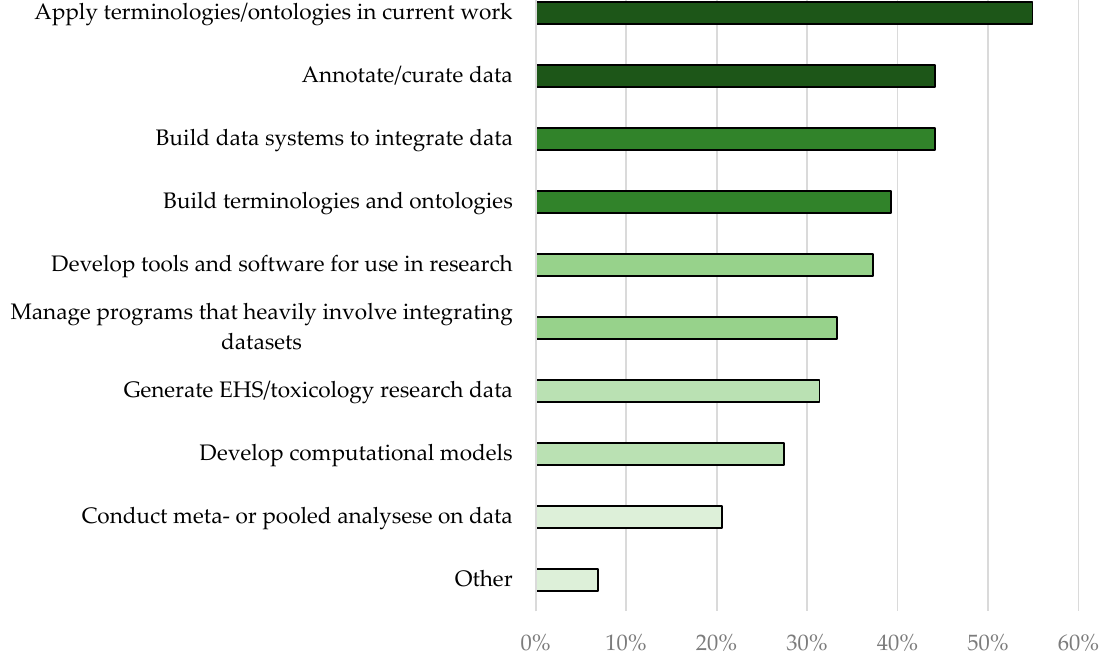
Figure 3. Proportions of workshop participants interested in the proposed activities.